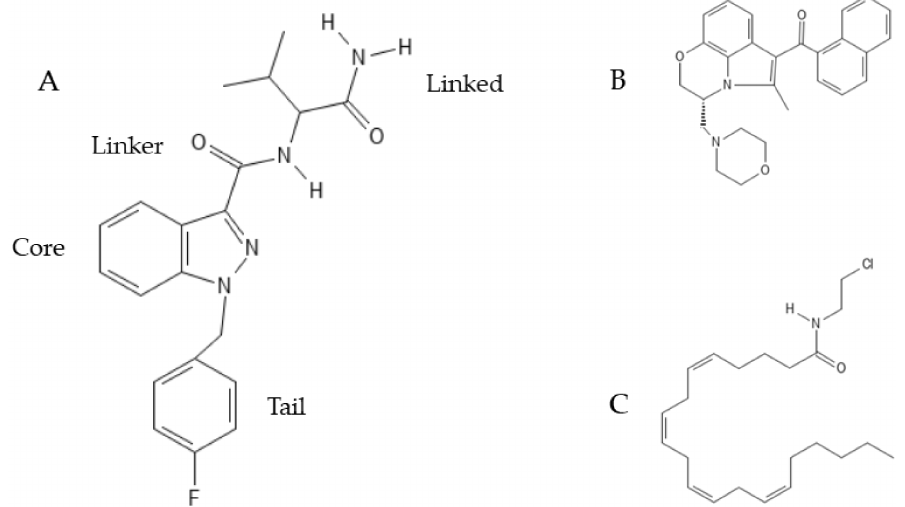
Figure 3. Synthetic cannabinoid structure and chemical structures of two synthetic